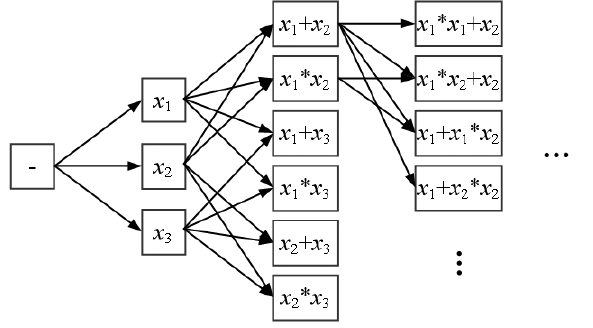
Figure 2. A small example of CIPER’s candidate model space (for simplicity, the coeffi- cients of the terms as well as the intercept term are omitted).